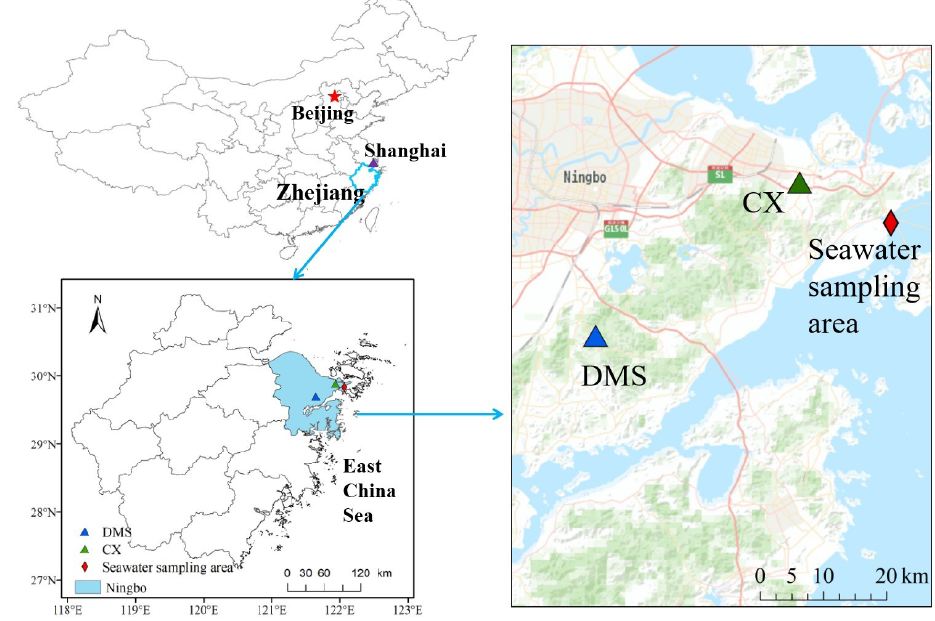
Figure 1. Locations of PM 2 . 5 (CX – industrial site; DMS – mountain site) and surface seawater sampling area.